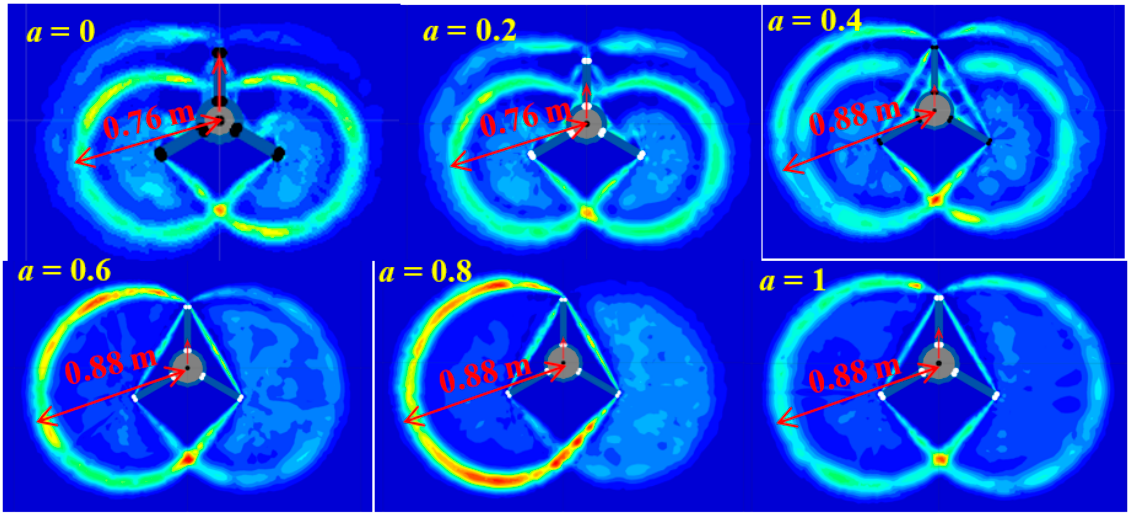
Figure 8. Influence of the different pile–soil interaction coefficients a on the shear plastic zone of the soil around the three-wing pile when lateral-load angle β = 0 and wing–diameter ratio is 2.3.